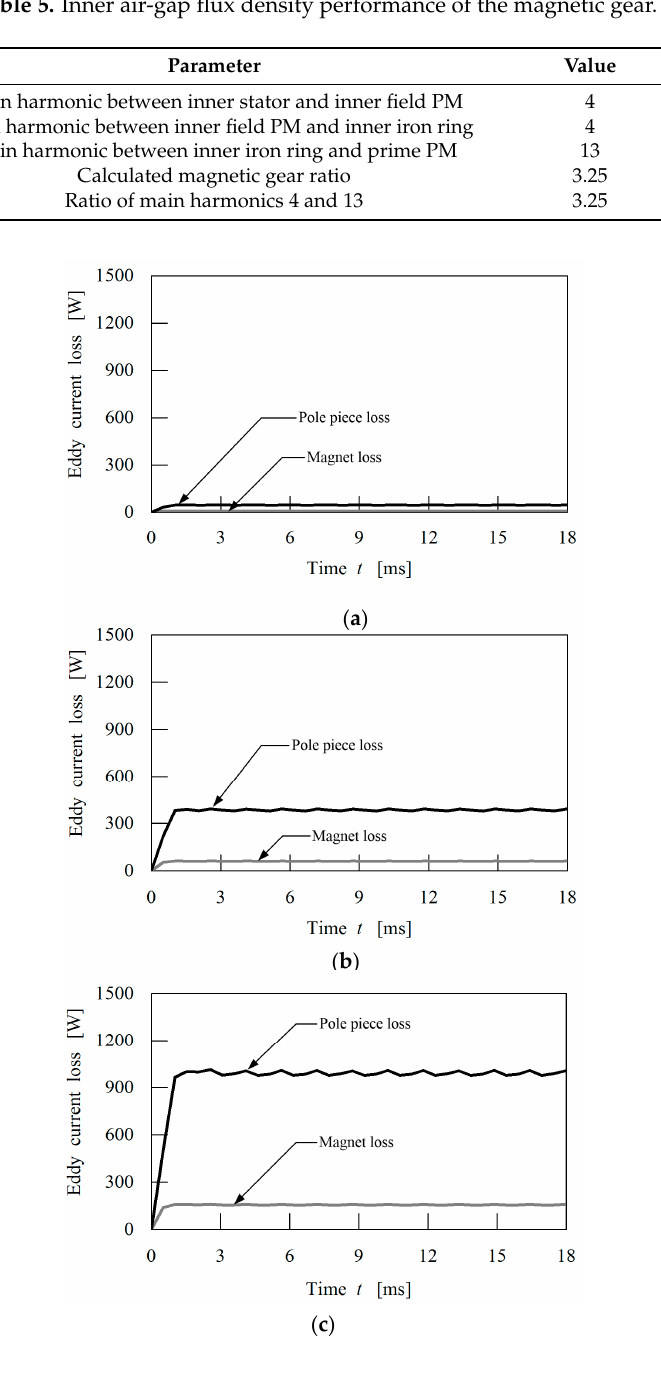
Ω at various speeds: